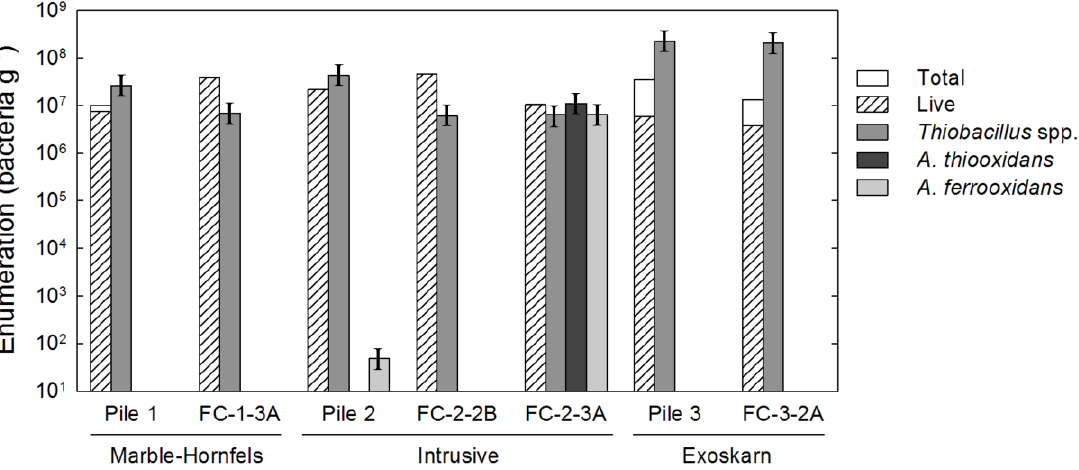
Figure 2. Bacterial enumerations performed on waste rock samples collected in February 2009. Enumerations of total and live bacteria performed using Live/Dead Baclight™. Culture-based enumeration of Thiobacillus spp., e.g., A. thiooxidans and A. ferrooxidans , was performed using the most probable number (MPN)